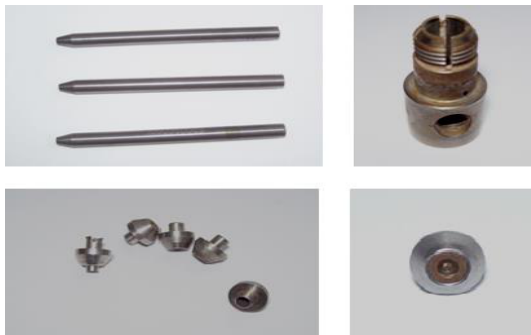
Fig. 1. Calibration tubes, collet mixing chamber and sapphire nozzle inserts by firm SynergicInc., (Provider